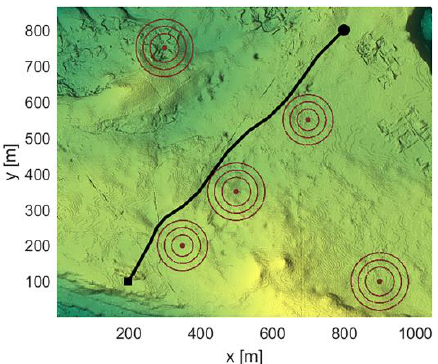
Figure 16. The top view of the paths generated by the PSO algorithm under five threats.